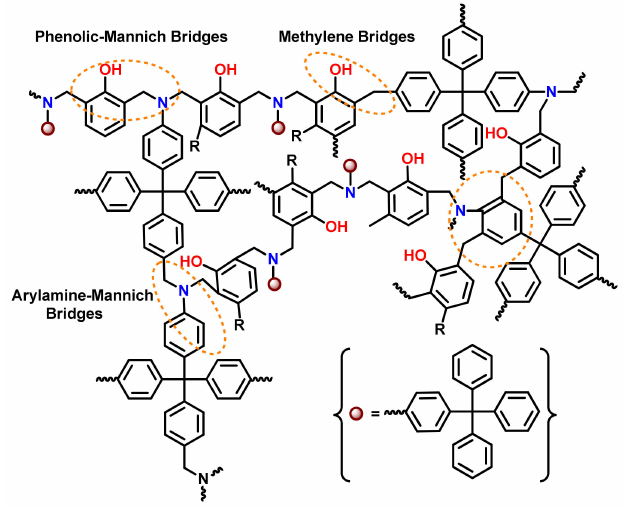
Figure 5. Polybenzoxazine framework with variable linkages in poly(C-ta) [131]. Copyright 2016. Reproduced with permission from Elsevier Ltd.